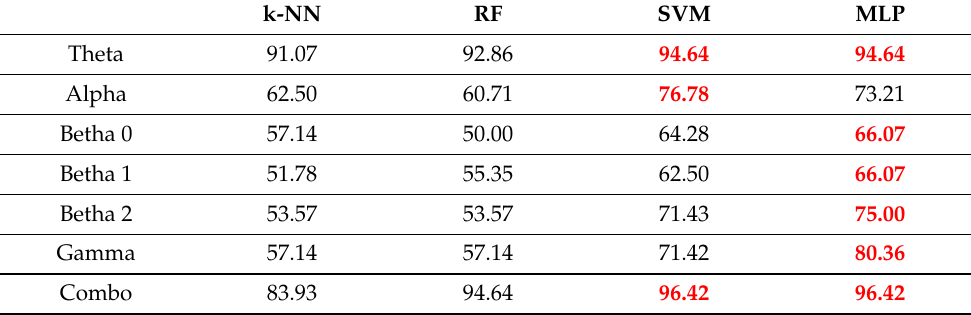
Table 3. Classification performances (in %) of different feature representations for the set of two classes: stress and relaxation . Numbers in bold and red highlight the maximum classification rates achieved in each column. COMBO refers to all extracted parameters in one feature-vector.